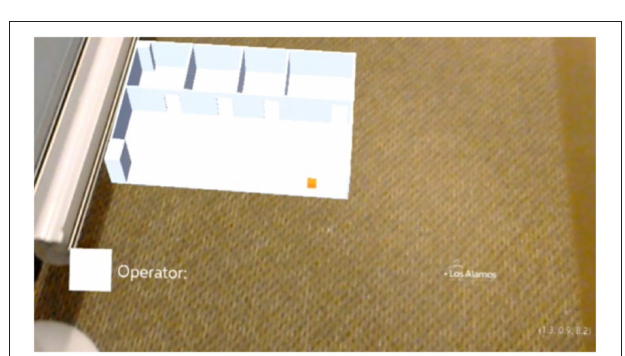
FIGURE 28 | Another instance of the operator moving throughout the facility while their position is captured on the